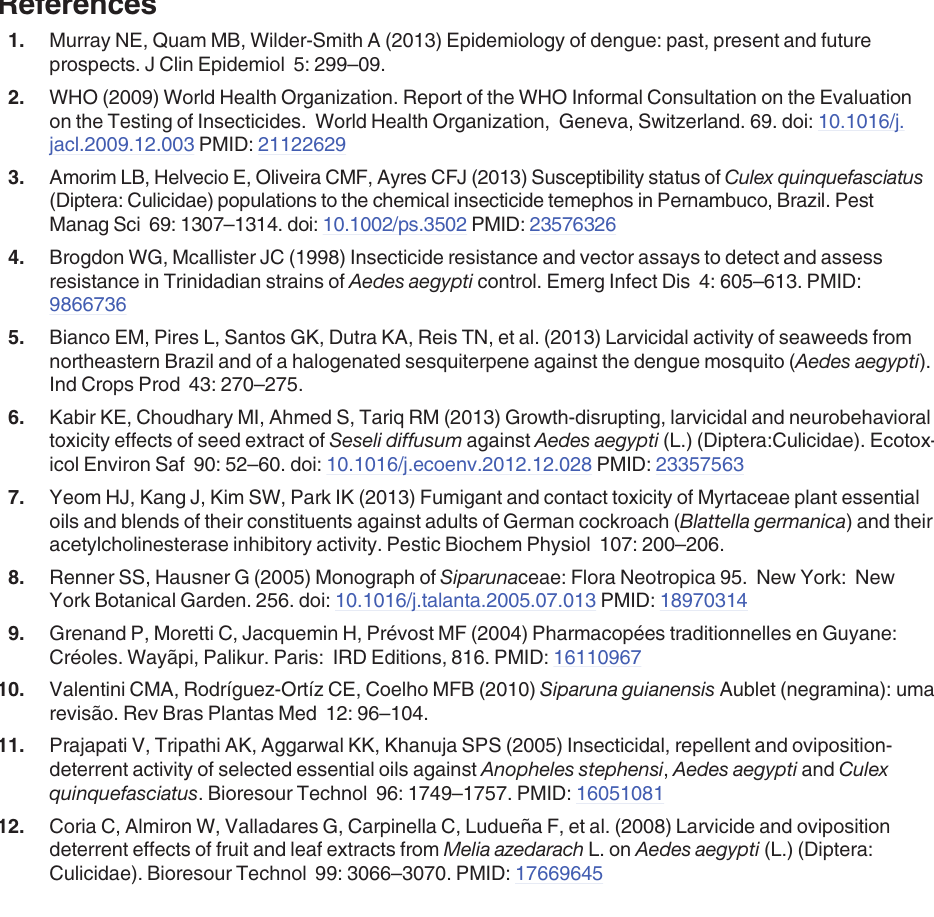
S1 Fig. Viability of C6/36 cells from A . albopictus treated with different concentrations of essential oils of S . guianensis